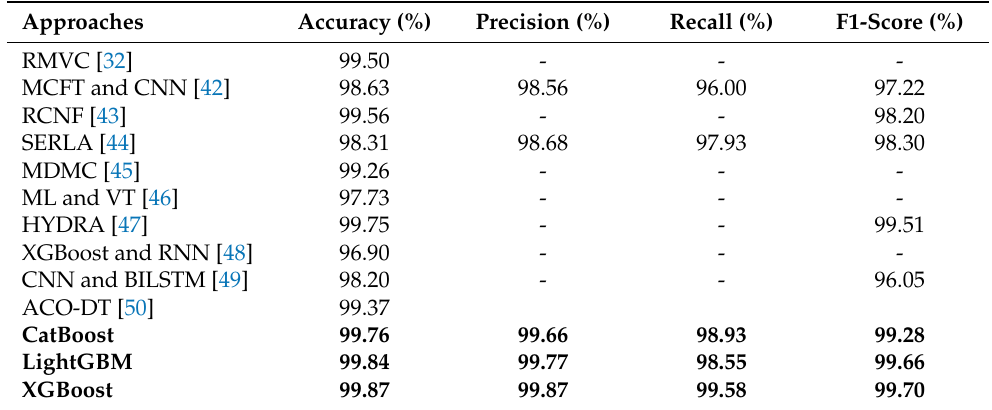
Table 8. Comparison with other